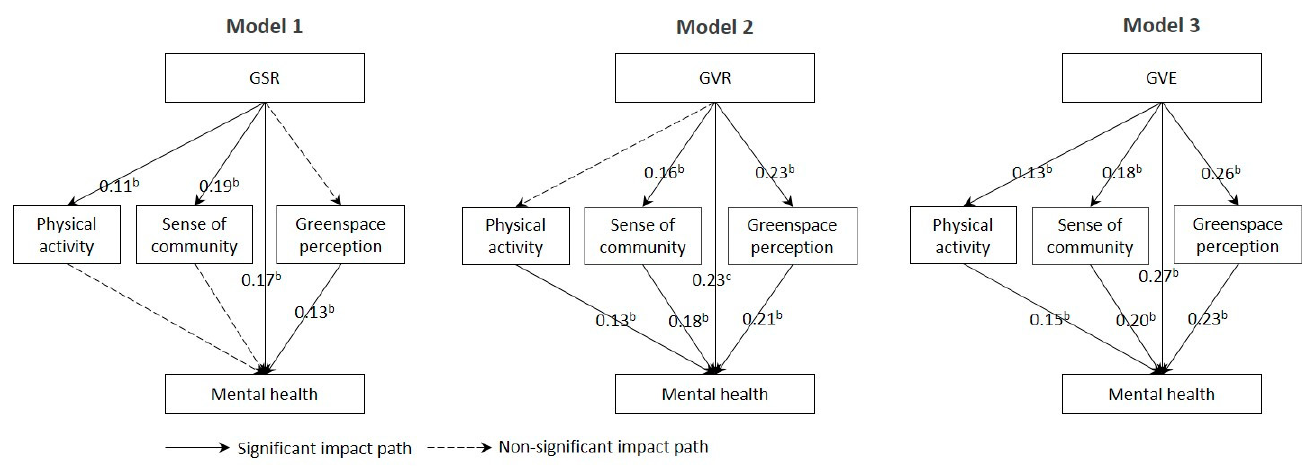
Figure 4. Structural model showing the estimated paths linking GSE to mental health. Note: GSE—greenspace exposure, GSR—greenspace ratio, GVR—green visual ratio, GVE—green visual exposure. The unstandardized regression weights are given for each path. The measurement model, control variables, covariance, and error terms are not shown here to enhance readability. b p < 0.05, c p < 0.1. Table 10. Total, direct, and indirect associations of GSE with mental health in the structural equa- tion model.